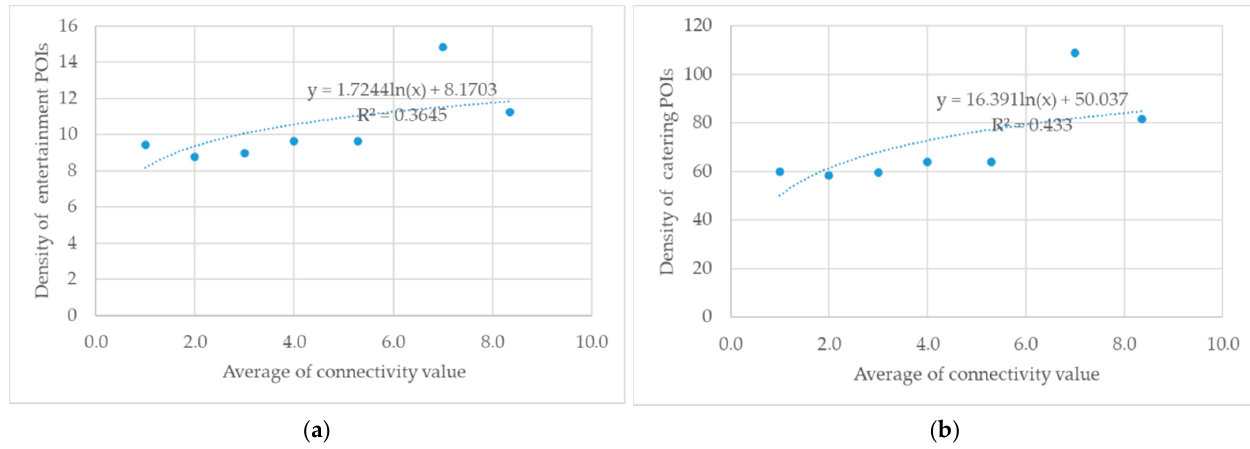
Figure 7. Scatter plot of average connectivity value and each density of two types of POIs: ( a ) entertainment; ( b ) catering.